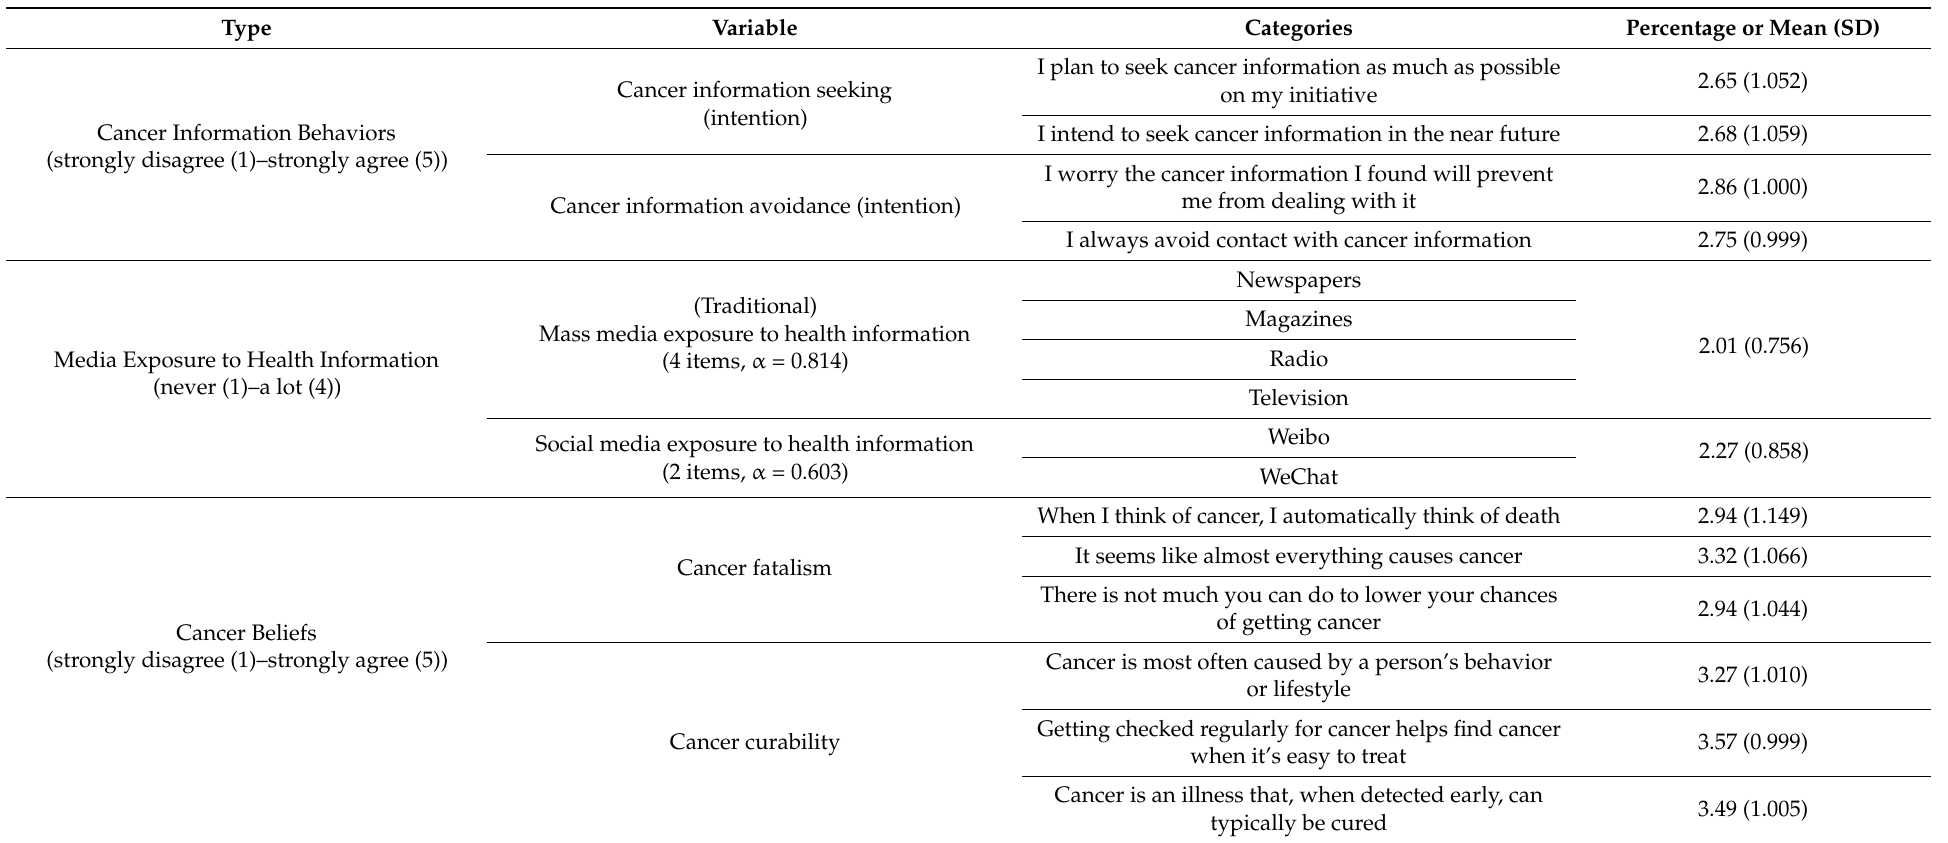
Table 1. Sample descriptive statistics ( N =